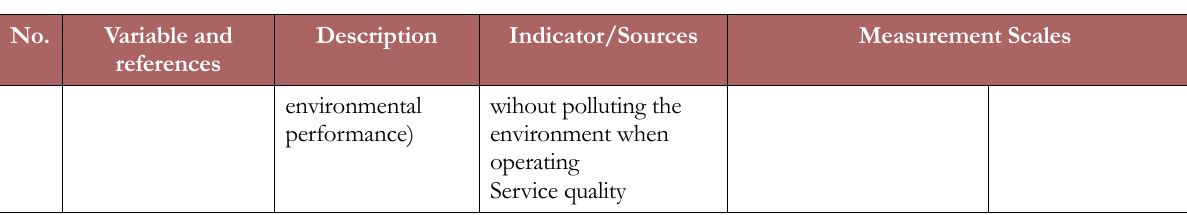
Table 2. Variable, Description, Indicator, and Measurement